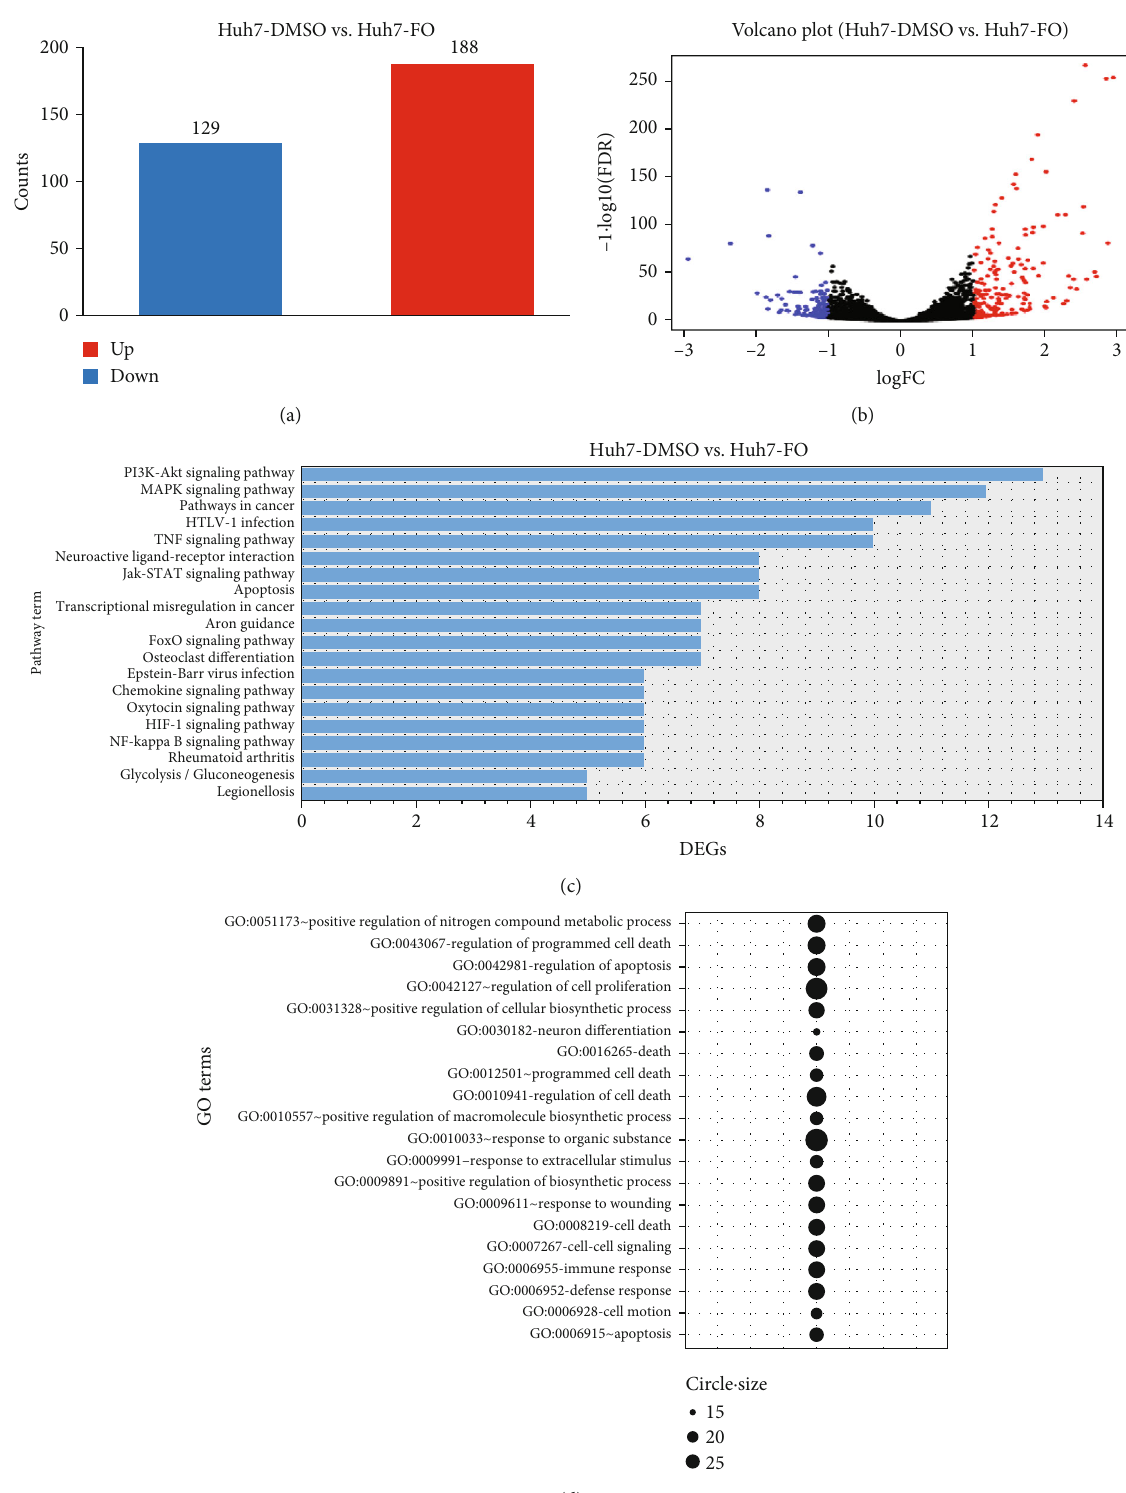
Figure 3: Bioinformatics analysis in FO-treated Huh7 cells. (a, b) Volcano plot of the di ff erentially expressed genes. The thresholds were log 2FC > 1 and adjusted P value < 0.05. Red dots indicate upregulated genes, and blue dots indicate downregulated genes. (c) Top 20 KEGG pathways with the most enriched di ff erentially expressed genes of RNA-Seq ( P < 0 : 01 ). (d) Bubble plot represents the top 20 gene sets with the most enriched di ff erential genes in the DAVID GO BP DIRECT annotation database obtained by comparing gene expression between Huh7 treated with FO and controls. The size of these bubbles represents the number of di ff erentially expressed genes, assigned to the GO BP